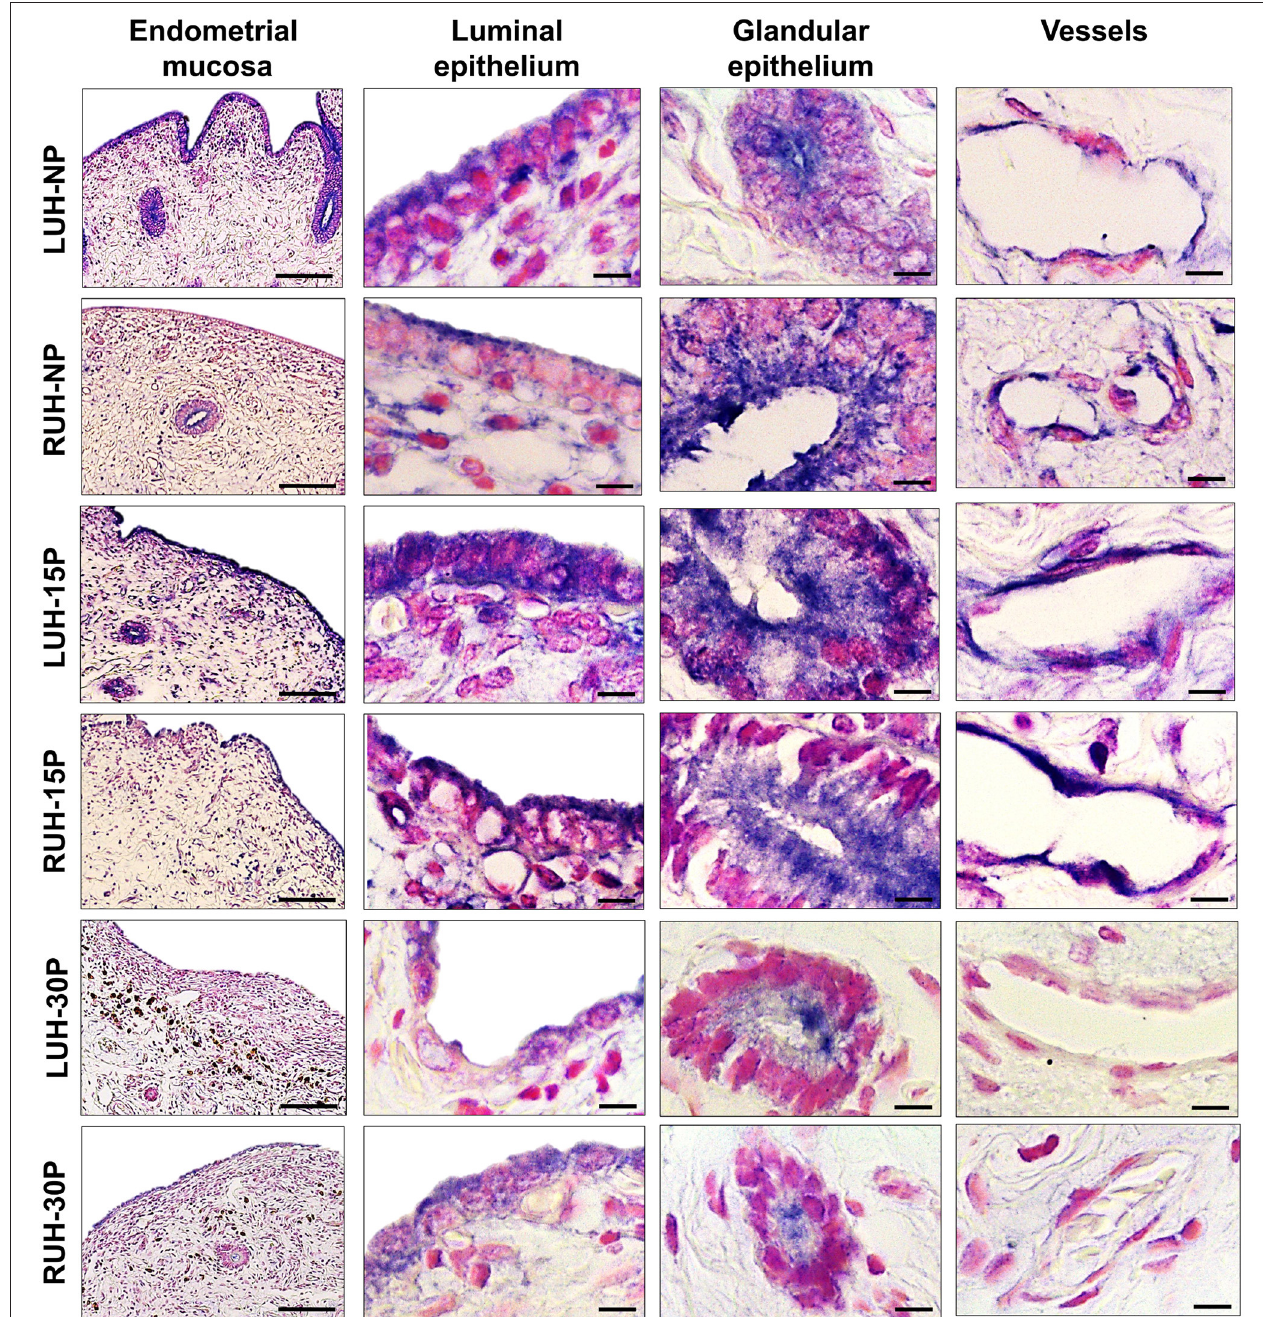
FIGURE 3 | Immunohistochemical localization of TrKA in the endometrial mucosa of alpacas, positive labeling gives a blue-violaceous coloration. A 10X magnification of endometria of the left uterine horn (LUH) and right uterine horn (RUH) of non-pregnant females (NP); 15 days-pregnant (15P); and 30 days-pregnant females (30P) is presented (scale bar = 100 µ m). Also, a 100X magnification of the luminal, glandular and vascular endothelium of the different physiological status is shown (scale bar = 10 µ m).